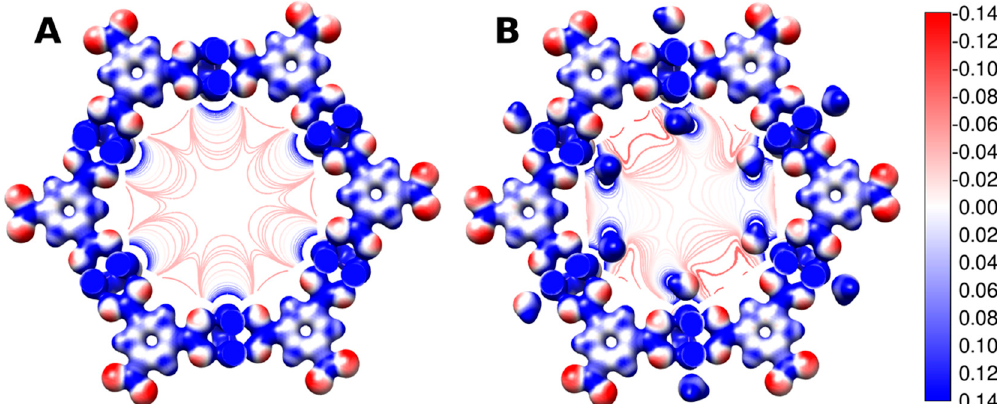
Figure 6. Electrostatic potential maps for the large cavity of HKUST-1 ( A ) without water molecules and ( B ) in the presence of water molecules, plotted both on the 0.05 a.u. isosurface of the electron density and as isocontour lines in the middle of the pore. The color scale for the maps is given on the right-hand side of the figure.